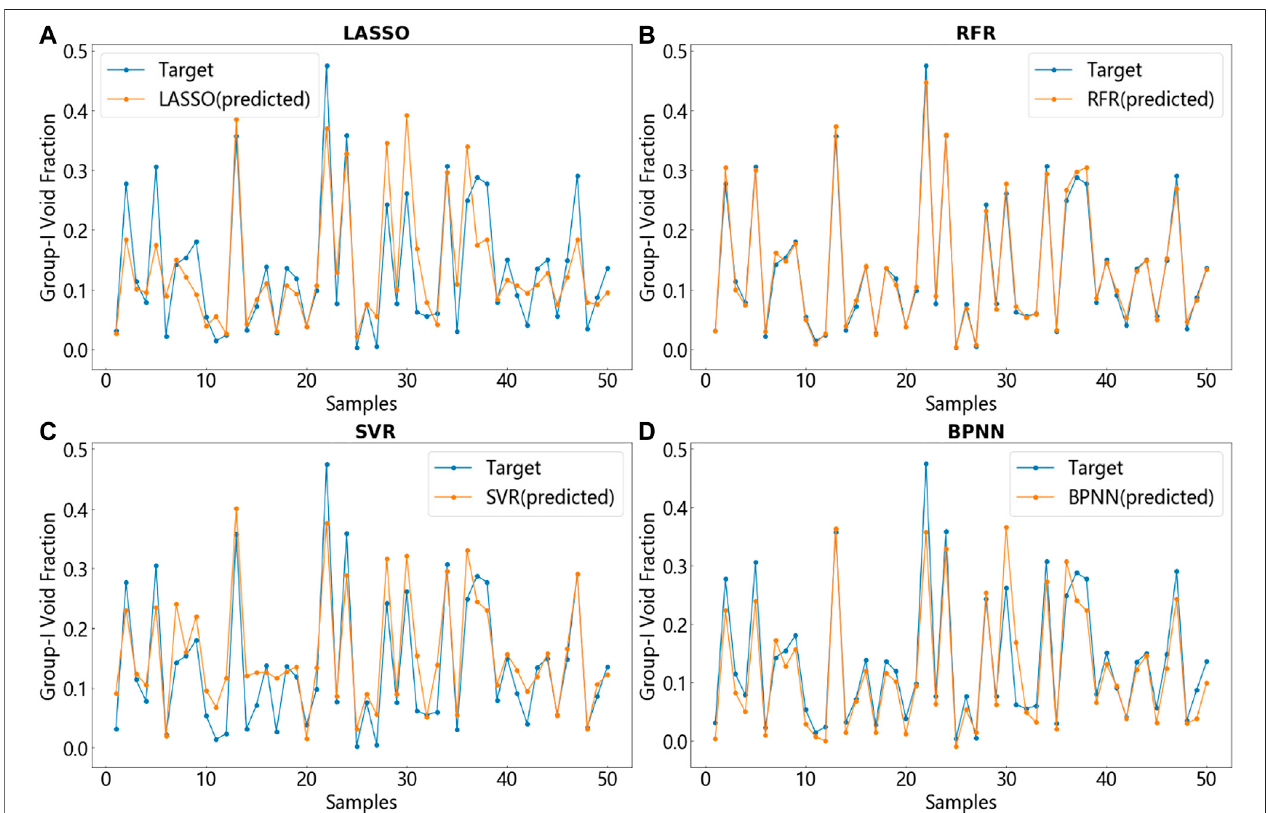
FIGURE 9 | Prediction of the group-I void fraction using four models and comparison with target values. (A) LASSO. (B) RFR. (C) SVR (D) BPNN.